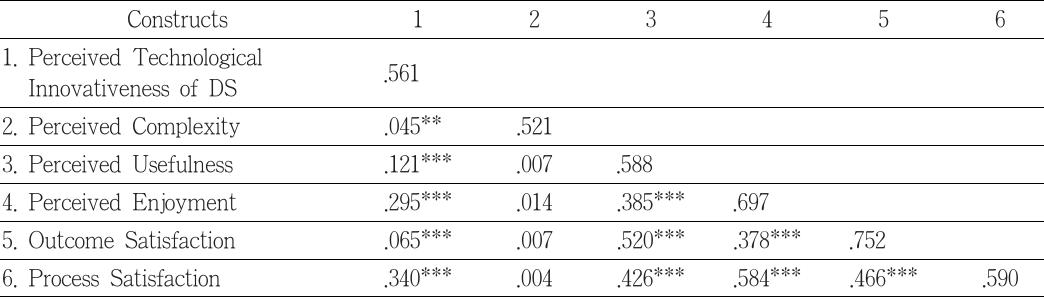
<Table 2> Measurement Model Correlation